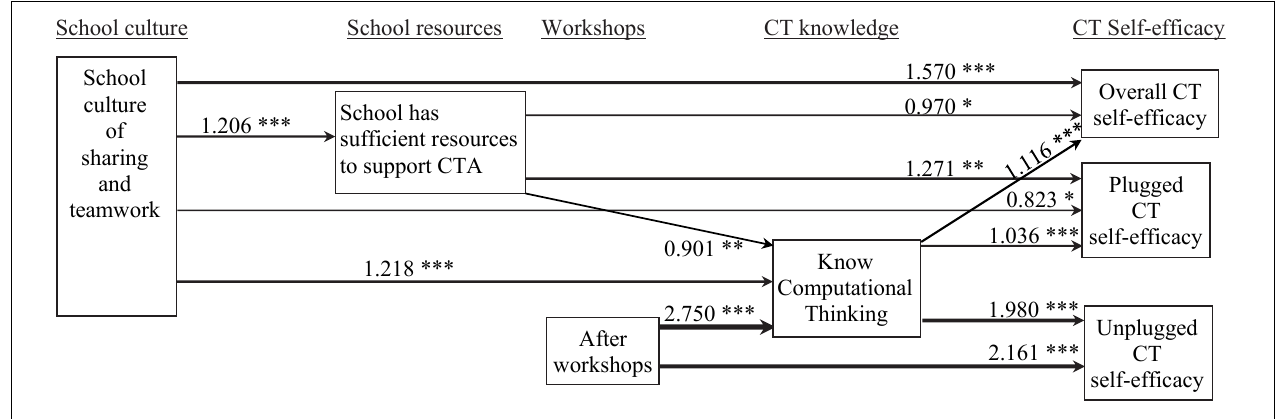
FIGURE 2 | Path analysis of antecedents of overall / plugged / unplugged computational thinking (CT) teaching self-efficacy. Thicker arrows indicate larger effect sizes. ∗ p < 0.05, ∗∗ p < 0.01, ∗∗∗ p < 0.001 5.2 Written Reflections and Interviews.